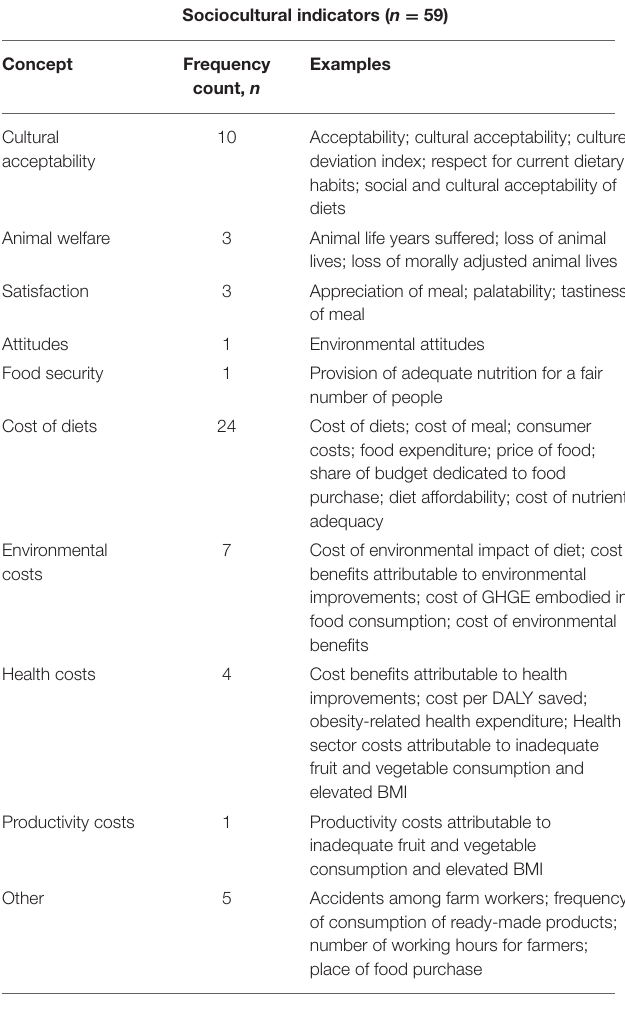
TABLE 3 | Sociocultural indicators by concept measured and frequency of use in the scoping